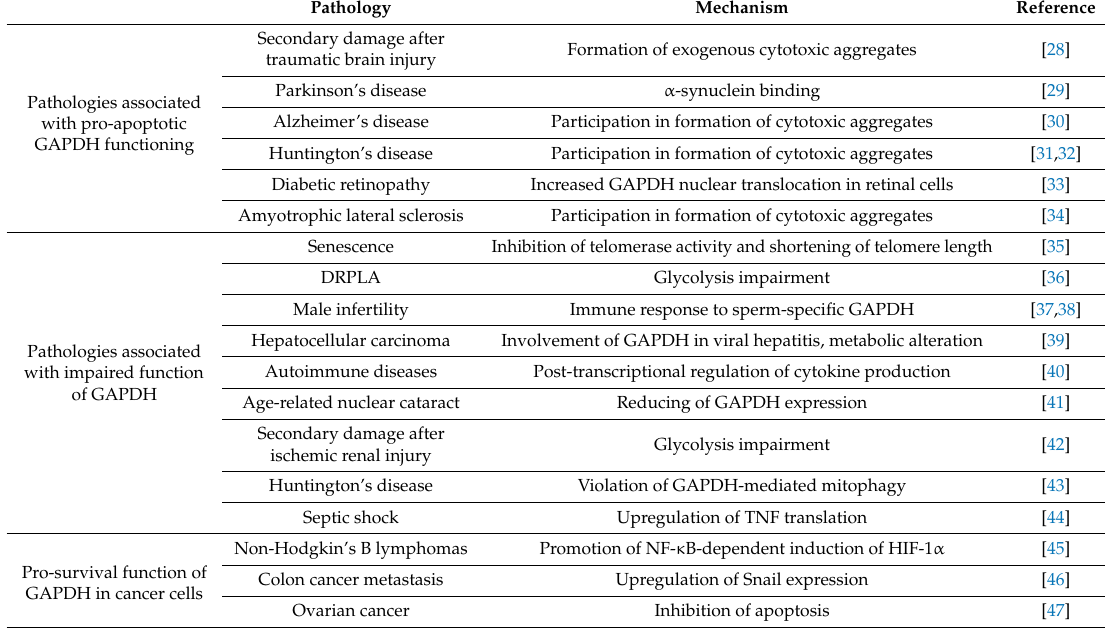
Table 1. Glyceraldehyde-3-phosphate dehydrogenase (GAPDH) as an important participant of pathological